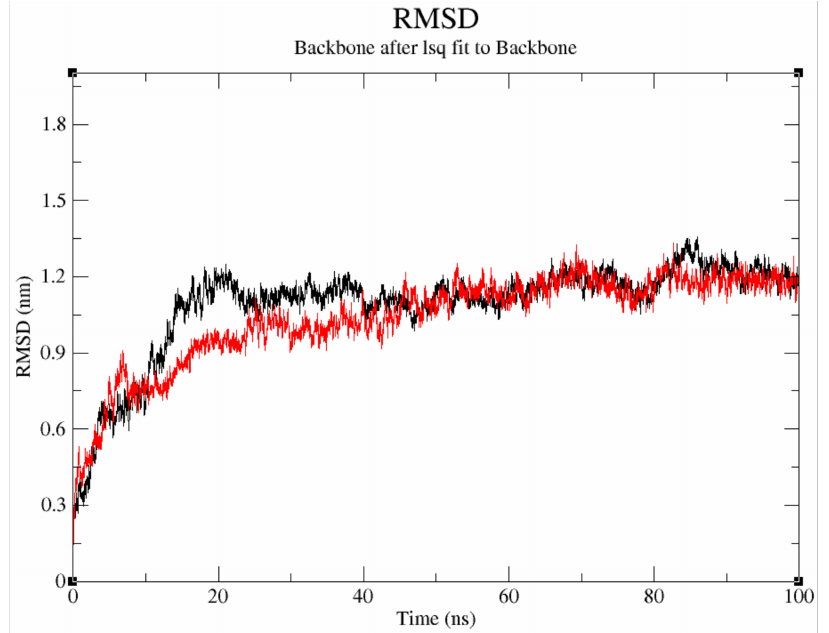
Figure 5. Root mean square deviation (RMSD) plot of fenoxaprop-p-ethyl (black) and sinigrin (red) ACCase complex structures over 100 ns simulation.